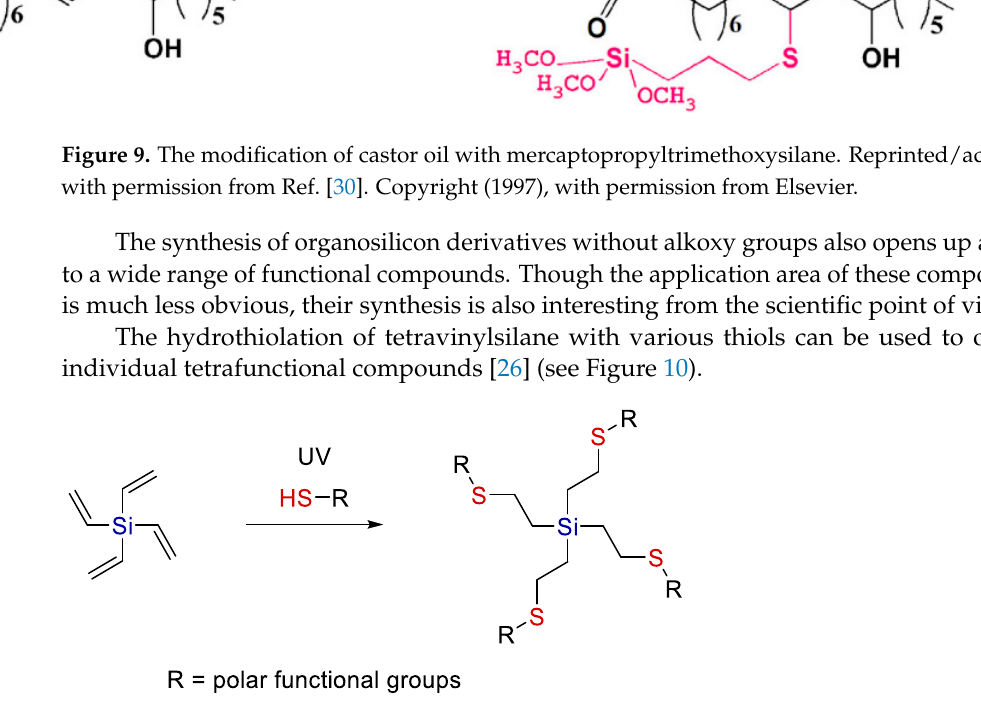
Figure 10. A scheme of modification of a tetrafunctional silane by thiol-ene addition [26].